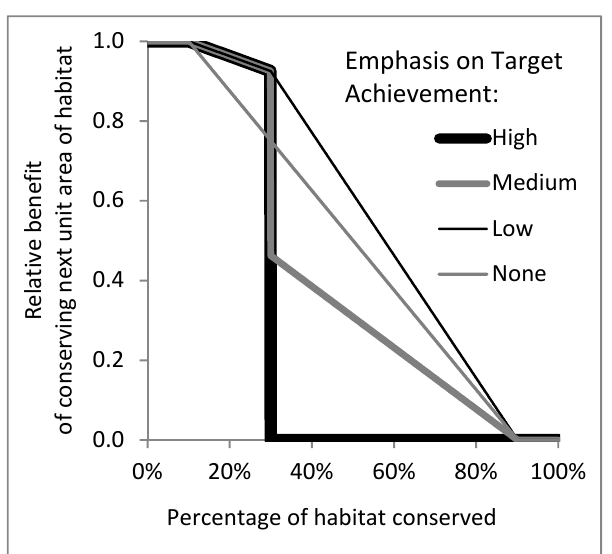
Figure 6. Four marginal value functions that exhibit differing emphases on target achievement. Traditional conservation planning identifies a representation target for how much of each habitat should be conserved in reserves. Here, are four marginal value functions (MVFs), three with a target of 30% and different “target emphasis” parameter values, and one with no target at all.